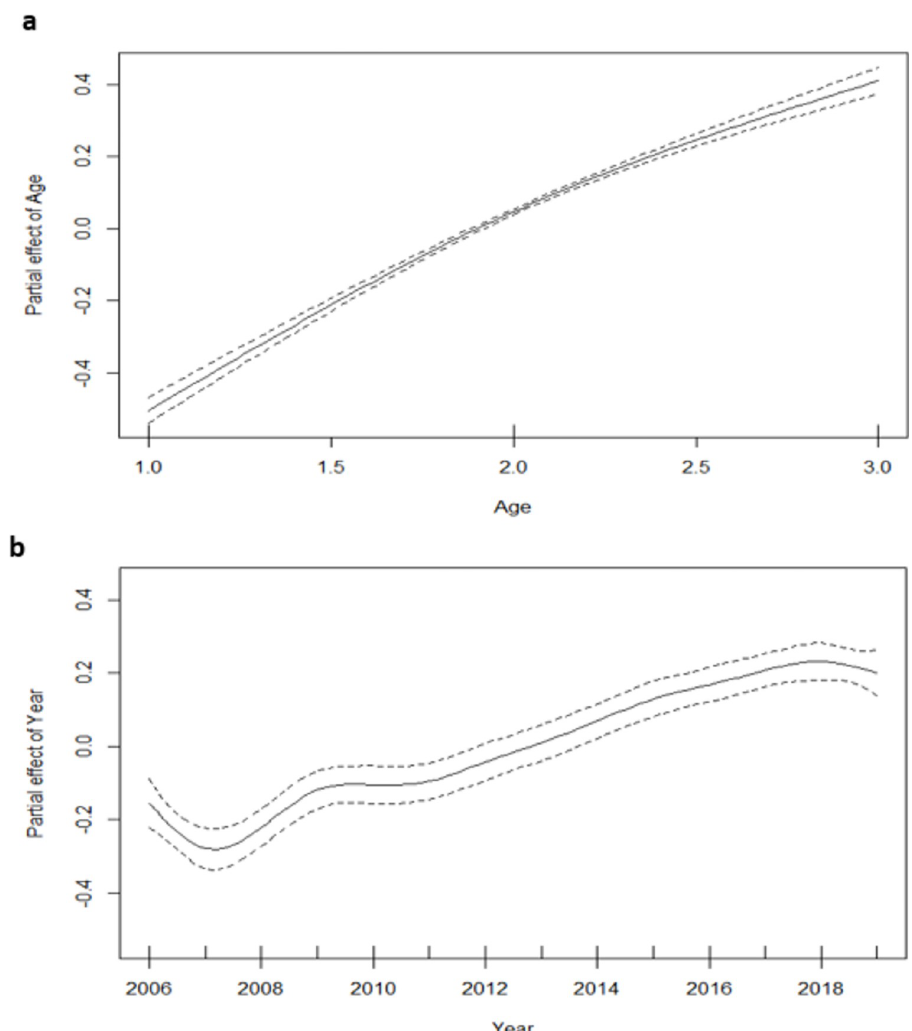
Fig 3. Plot of non-linear effects of age and year of amputation on limb amputation risk. The solid black lines represent the estimated non-linear effects of the log relative risk of limb amputation, and the interrupted lines represent the corresponding 95% Confidence Interval of the estimated risk. Age 0–49 years = 1.0, 50–74 years = 2.0 and 75+ years =